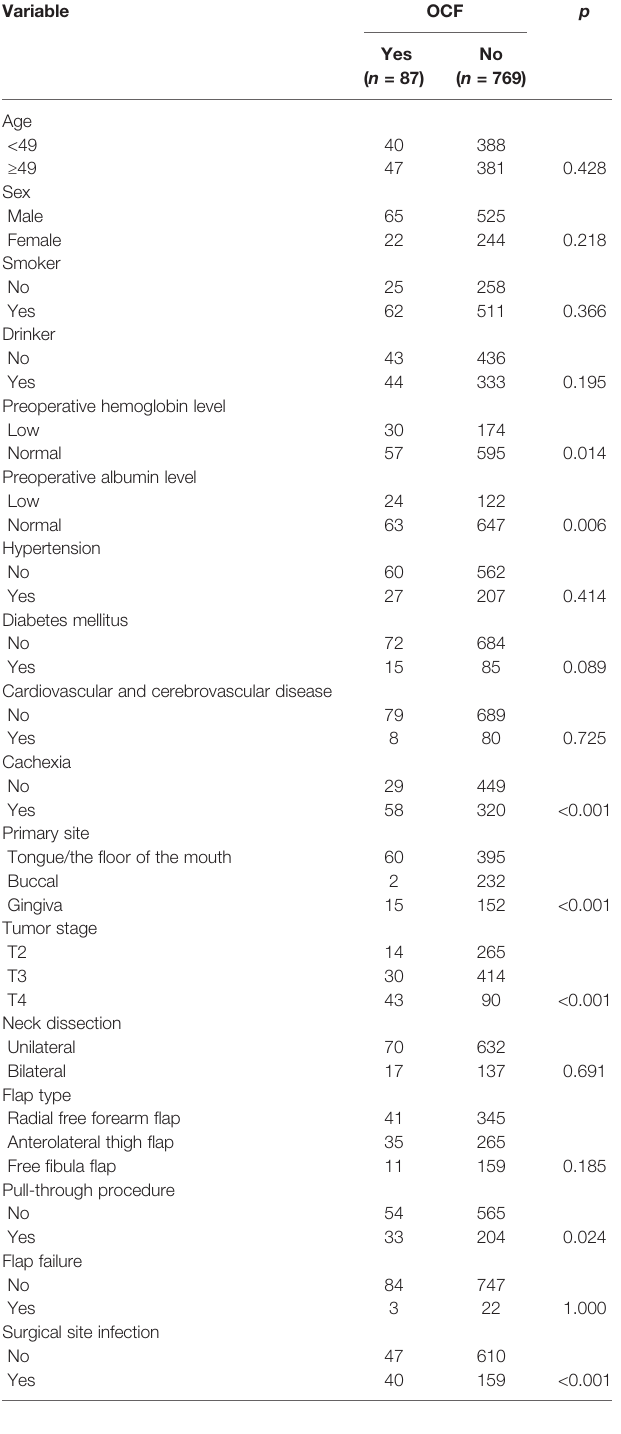
TABLE 2 | Univariate analysis of the association between clinicopathologic variables and orocutaneous fi stula (OCF) development. Variable